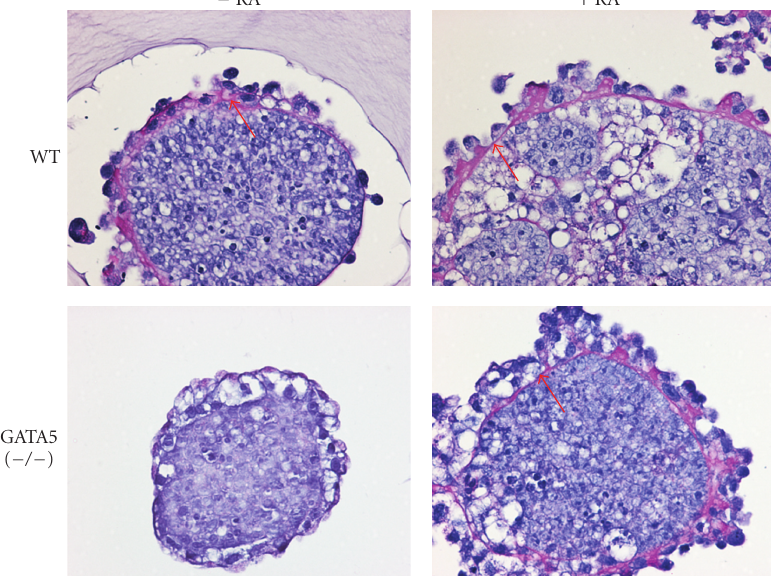
Figure 3: Primitive endoderm di ff erentiation and the absence of the basement membrane in GATA5-deficient embryoid bodies. Wildtype and GATA5 ( − / − ) ES cells were cultured in medium lacking LIF in suspension to allow the formation of cell aggregates on Petri dishes, with or without retinoic acid (1 μ M) for 4 days. The embryoid bodies from a 4-day suspension culture were fixed, embedded in para ffi n, sectioned, and subjected to PAS staining to detect the basement membrane. Representative stainings are shown (200 × ). Spheroids of GATA4 ( − / − ) and GATA6 ( − / − ) ES cells were previously published [25] and showed that endoderm formation is impaired in GATA4 ( − / − ) ES cell spheroids without RA. Endoderm formation in GATA4 ( − / − ) ES cell spheroids can be restored by treatment with RA for 4 days. Spheroid of GATA6 ( − / − ) ES cells lacked endoderm formation that cannot be restored with RA treatment [25]